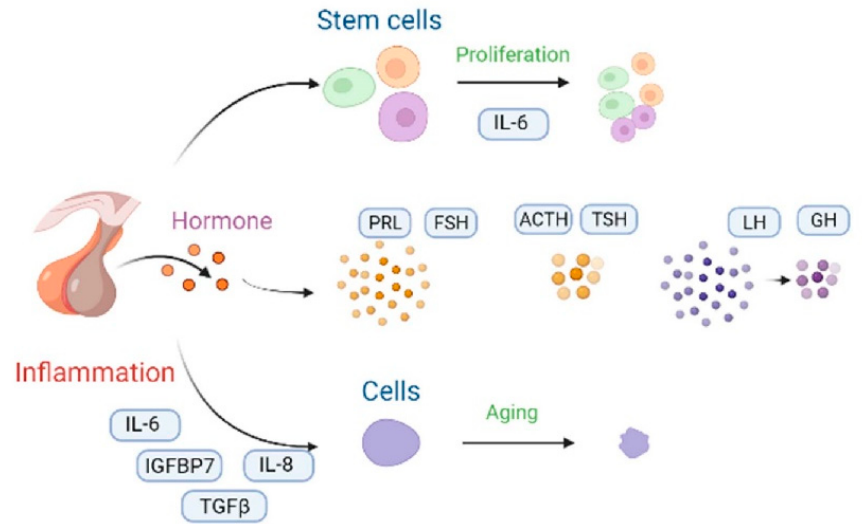
Figure 7. The changes and molecular mechanisms of the pituitary aging hormone. Proliferation of the pituitary stem cells can be enhanced by IL-6 supplementation, and they can also achieve anti-aging purposes [28]. When the levels of the pituitary aging hormones changed, the levels of prolactin (PRL) and the follicle-stimulating hormone (FSH) increased [32], whereas the adrenocorticotropic hormone (ACTH) and the thyroid-stimulating hormone (TSH) did not change significantly [34]. Moreover, the luteinizing hormone (LH) and the growth hormone (GH) levels decreased [31]. The inflammatory factors, including IL-6, IGHBP7, IL-8, and TGF β activated the cellular senescence inflammatory network [36–38]. The black curved arrow represents the transformation method.